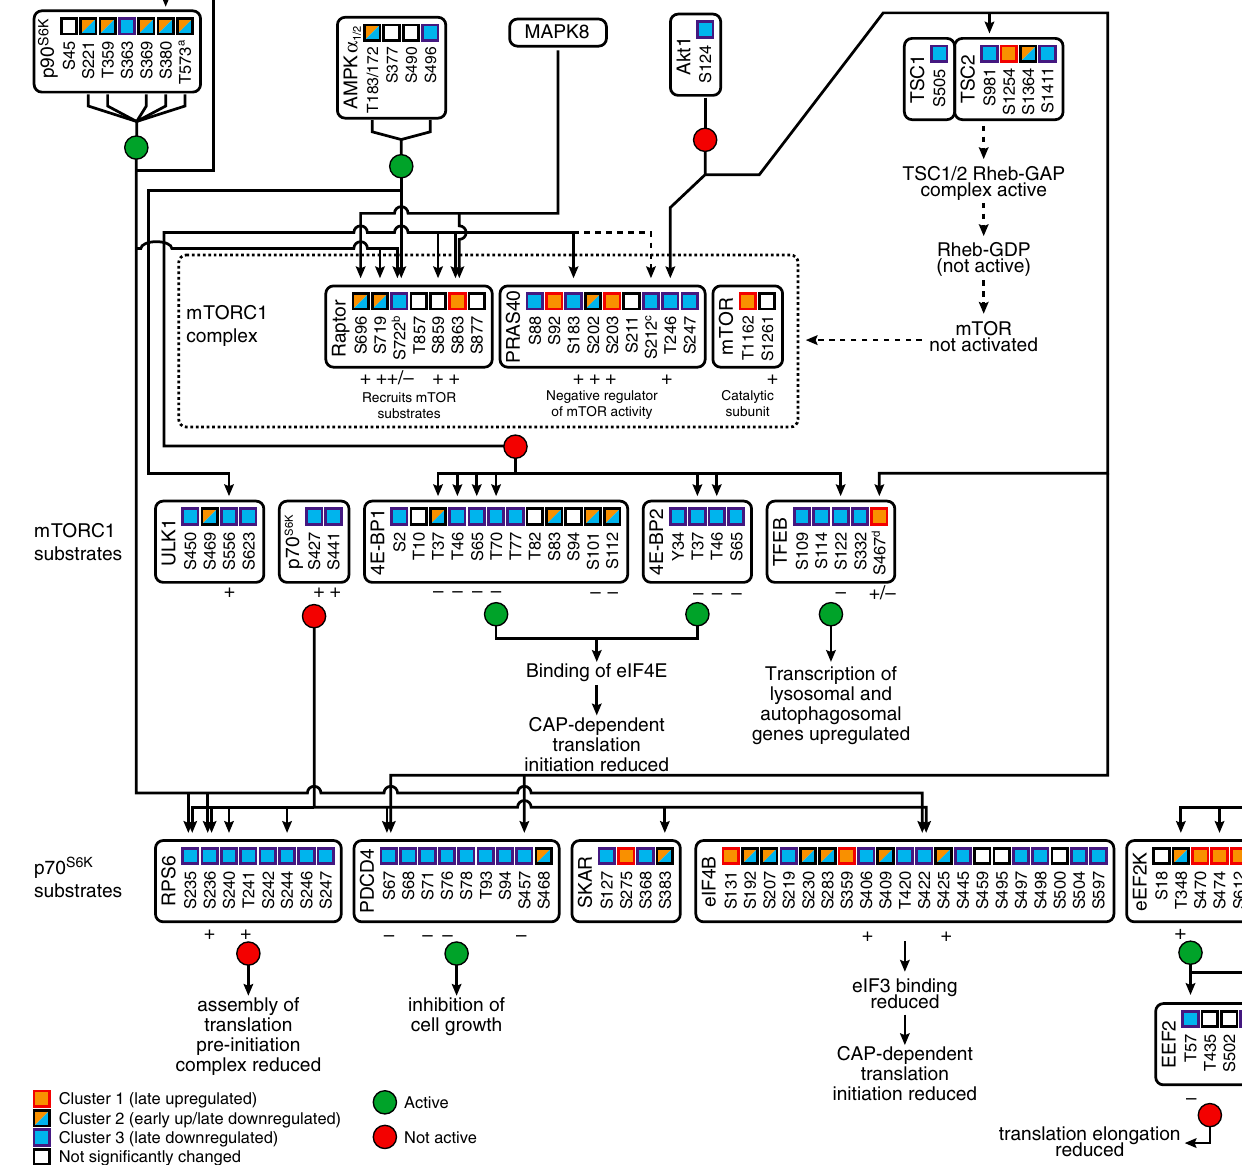
Fig. 3 Overview of phosphorylation events in the mTORC1 signalling in CVB3-infected cells. Analysis of phosphosites on proteins in the mTORC1 signalling network and some upstream kinases, restricted to these kinases of which sites on the mTORC1 complex are detected. Supplementary Data 4 list the detected phosphosites and the clusters to which signi fi cantly changed sites belong. For a detailed description, see the main text. The effect of the phosphorylation on protein activity is denoted with plus sign and minus sign, indicating increase and decrease, respectively. In case a site has multiple phosphorylation forms, the pattern for the lowest detected phosphorylation multiplicity is